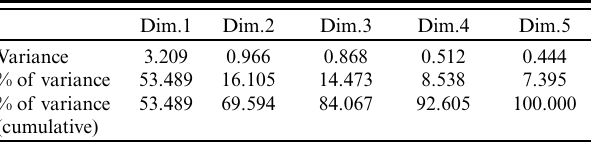
Table 2 . Leading factors behind panda loans: Eigenvalues, percentage of variance, and cumulative percentage of variance explained by the first five dimensions (Dim.) extracted by the factor analysis. Dim.1 Dim.2